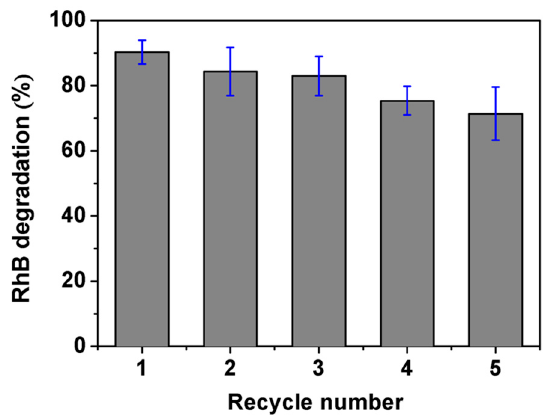
Figure 8. Five repeated photocatalytic degradation reactions on the Ag ‐ 8h/PDA/ZnO@GMF sub ‐